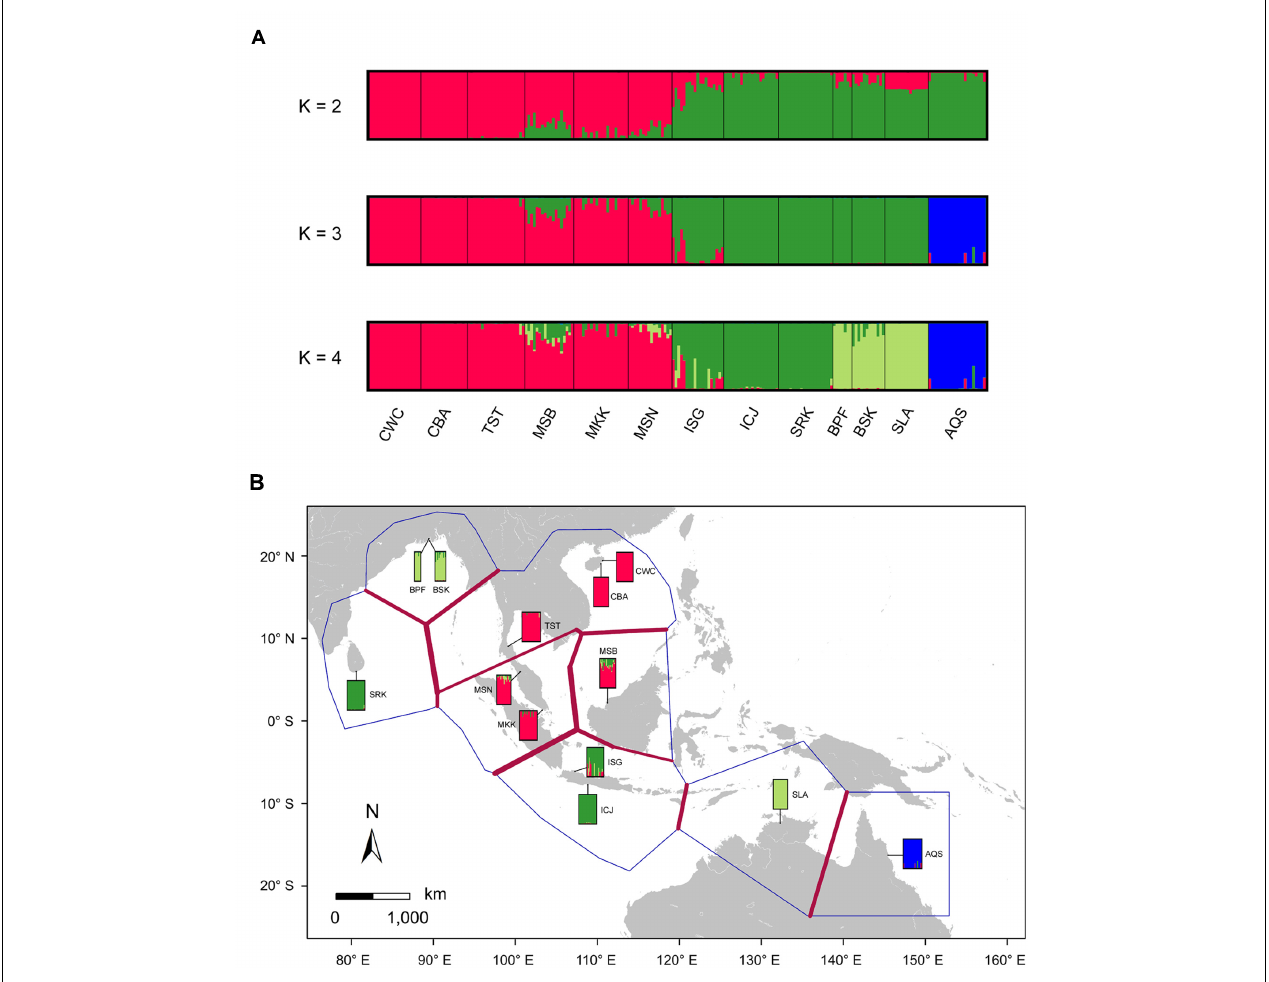
FIGURE 3 | Likely genetic clusters and geographical barriers existing among the 12 populations of S. caseolaris and the single population of S. lanceolata . (A) Bayesian clustering analysis of the five nuclear genes implemented in STRUCTURE. To illustrate the hierarchical population structure across the IWP region, we show clustering with the best-fitting model of K = 2, as well as K = 3 and K = 4. (B) Putative geographical barriers identifed within the IWP regions. The bars show the output of Bayesian clustering analysis with K = 4. Population abbreviations are defined in Table 1 .